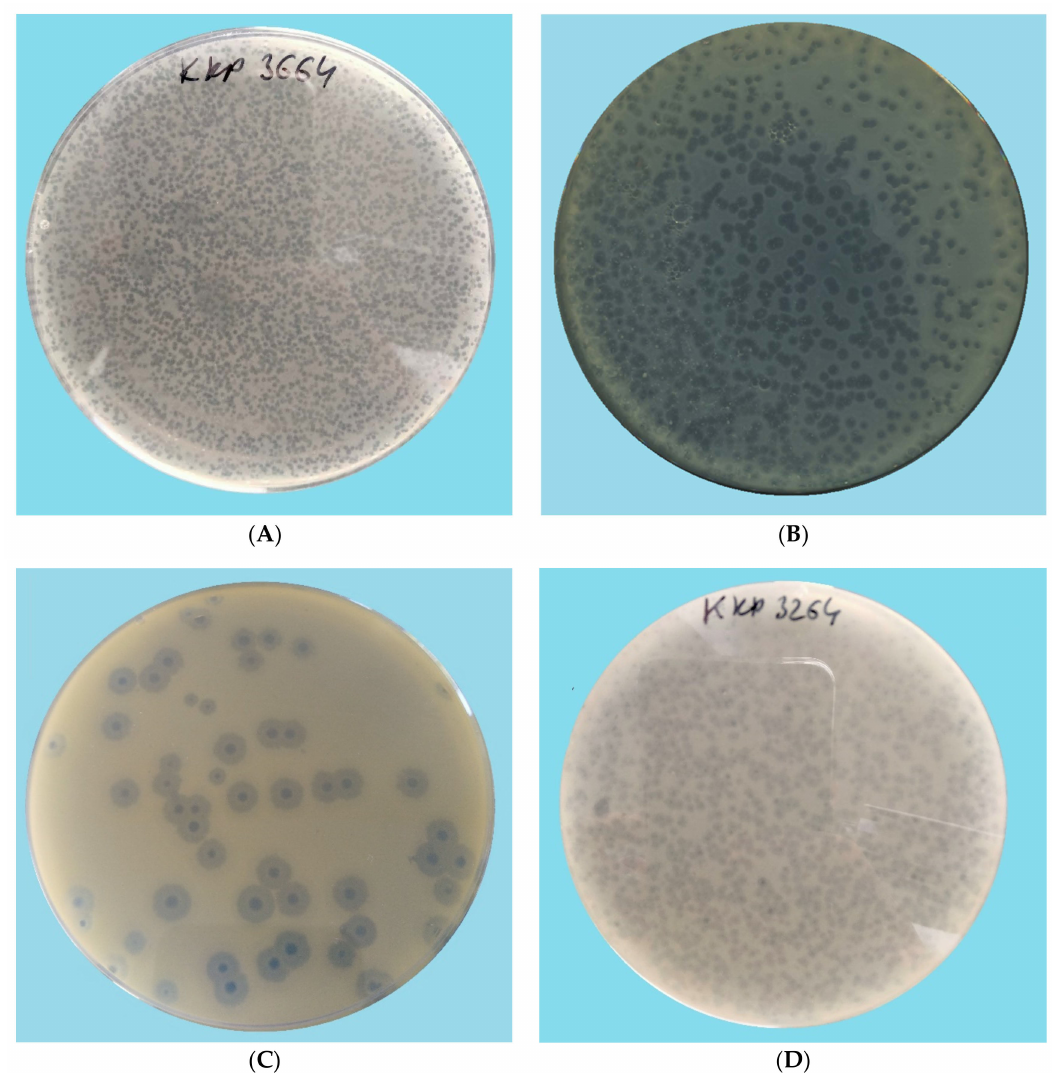
Figure 1. Morphology of phage plaques: ( A ) Citrobacter phage KKP 3664, ( B ) Enterobacter phage KKP 3262, ( C ) Enterobacter phage KKP 3263, ( D ) Serratia phage KKP 3264. Phages were plated in half-strength Luria-Bertani ( 1 24 h liquid culture of host bacteria. Plates were incubated at 30 ◦ C and observed at 24